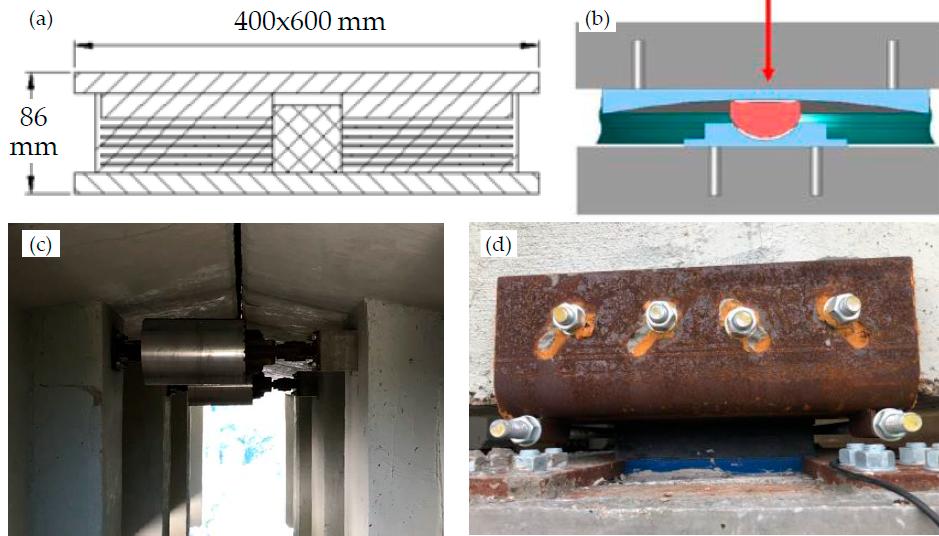
Figure 4. Retrofitting works for both bridges: scheme of ( a ) LRB isolators and ( b ) SFPS bearings; photos of the ( c ) seismic dampers and ( d ) LRB isolators mounted on the B1 bridge.